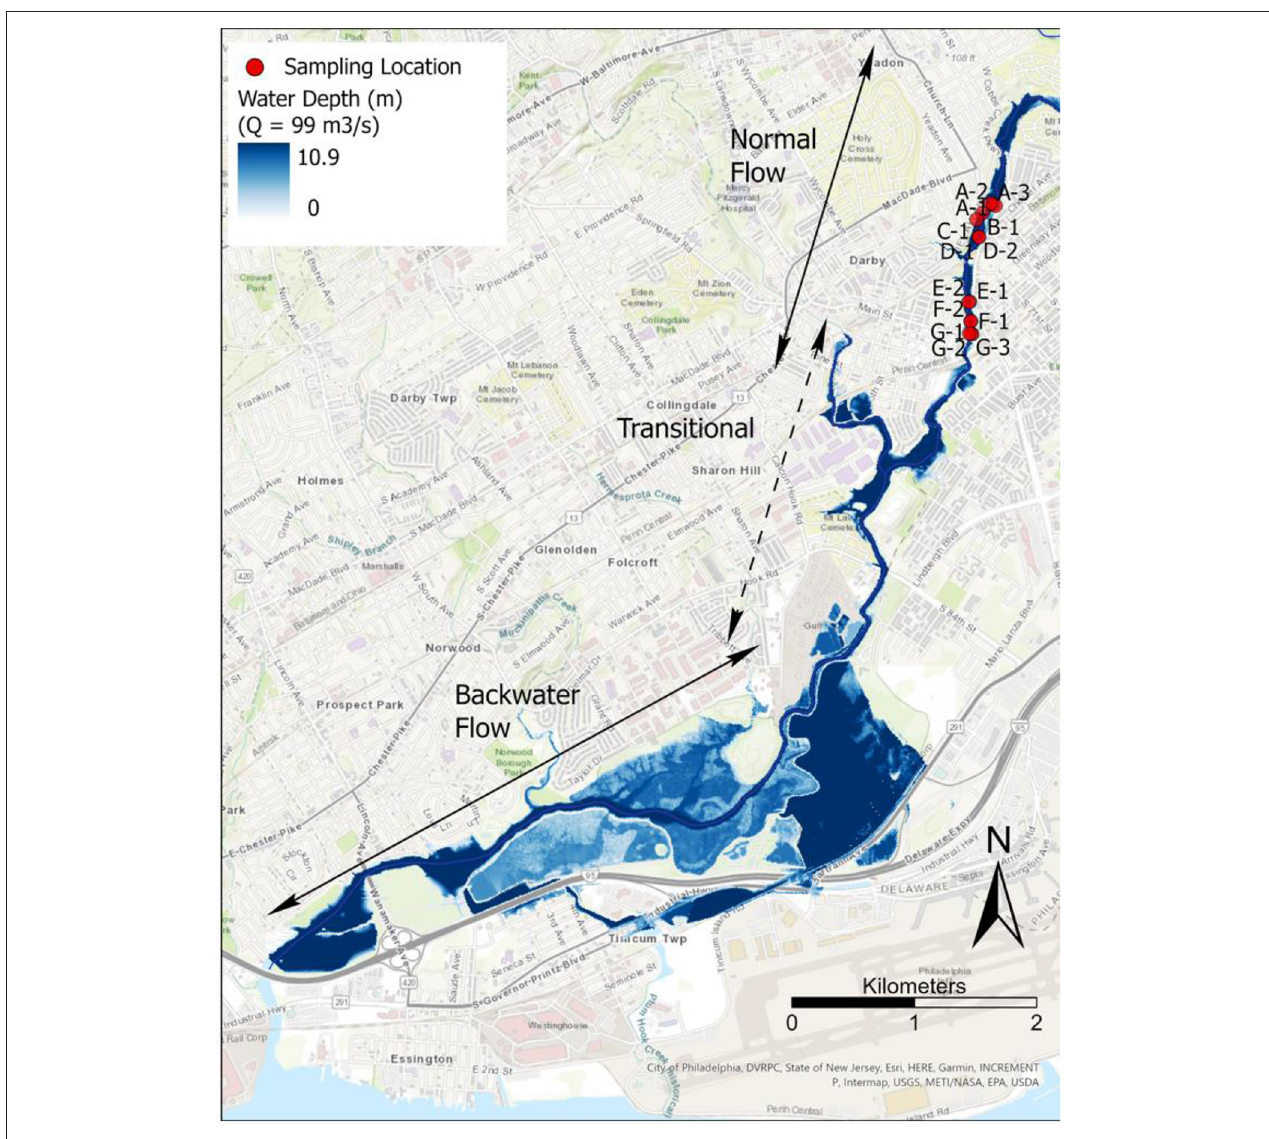
FIGURE 2 | Twenty-eight soil samples were collected in Darby Creek from 14